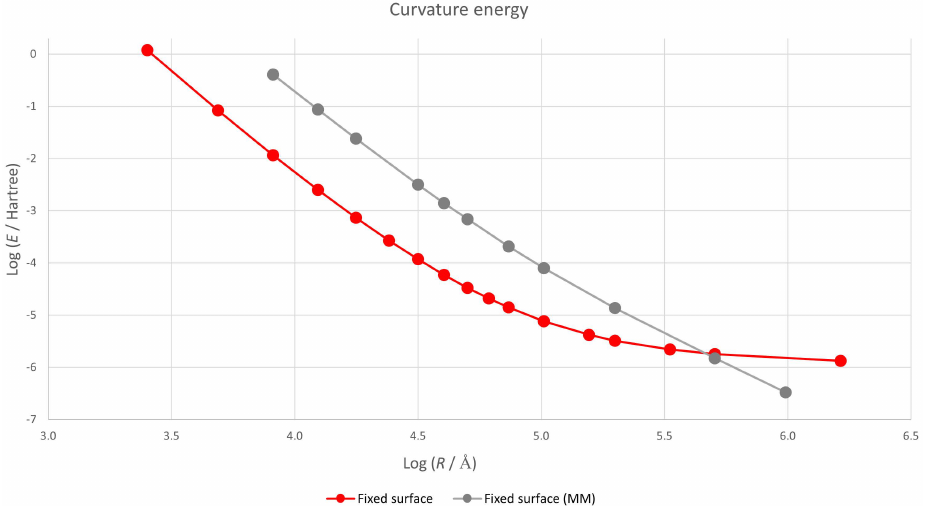
Figure 4. Log–log plot of the energy of a spherical graphene flake as a function of its curvature. Flat configuration is taken as energy origin. Lines are merely guides for the